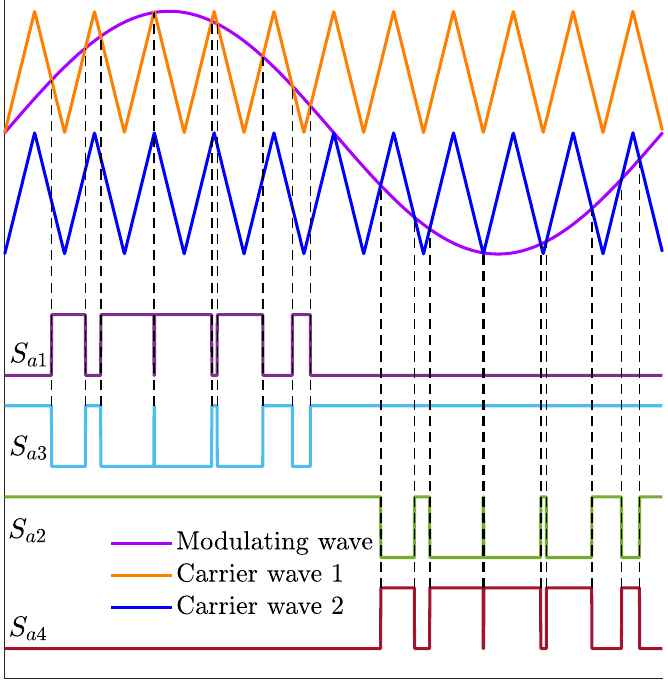
Figure 3. Conventional CBPWM with two carriers.